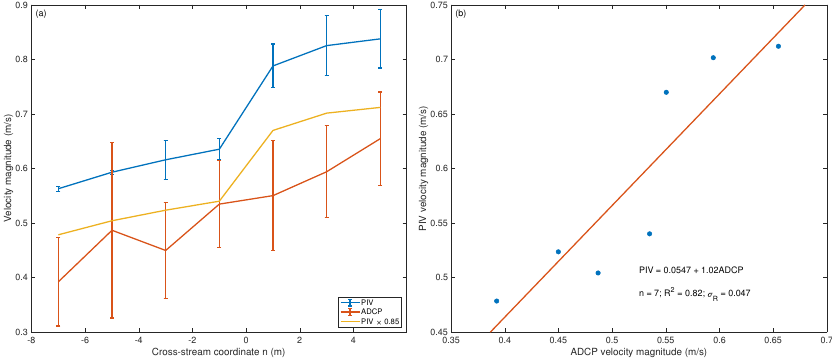
Figure 5. ( a ) Comparison of PIV-derived velocities and ADCP measurements along cross section 1. ( b ) Accuracy assessment of PIV-derived depth-averaged velocities via linear